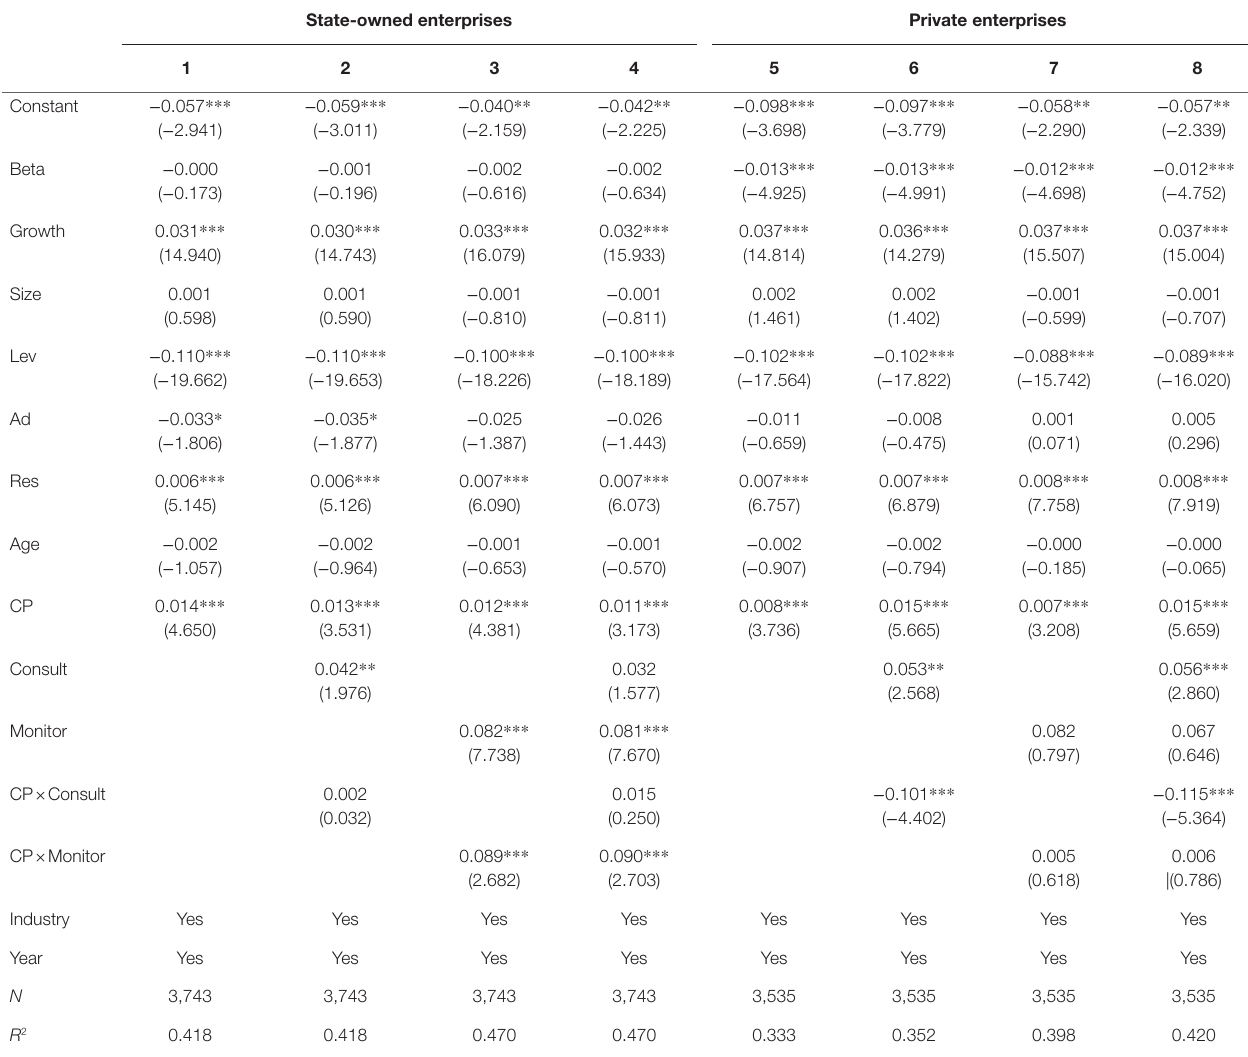
TABLE 3 | Regression results of the functions of the BOD in